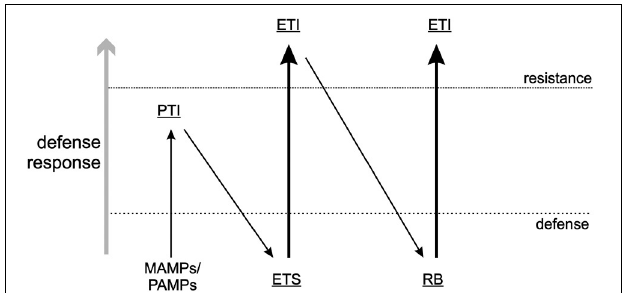
FIGURE 1 | Zig-zag-model. A visual presentation of the arms race between pathogen and host according to Jones and Dangl (2006). Here, a slightly modified version of that model is presented and as described in this review. MAMPs/PAMPs, Microbe/Pathogen associated molecular patterns; PTI, PAMP triggered immunity; ETS, Effector triggered susceptibility; ETI, Effector-triggered immunity; RB, resistance